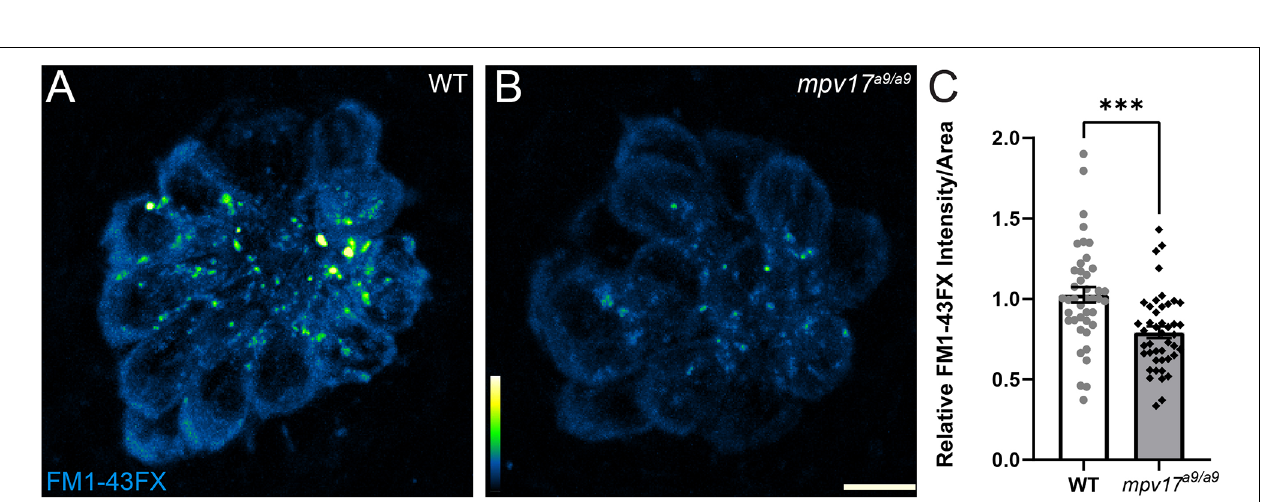
FIGURE 2 | mpv17 a9/a9 hair cells have hyperpolarized mitochondria. (A–C, E–G) Maximum-intensity projections of confocal images displaying WT (A–C) and mpv17 a9/a9 (E–G) neuromasts with DAPI-labeled hair cells (A–E) and staining with MitoTracker Red CMXRos (B–F) and MitoTracker Deep Red (C–G) . (D–H) Mean intensities for both MitoTracker Red CMXRos (D) and MitoTracker Deep Red (H) are elevated in mpv17 a9/a9 neuromasts ( ∗ P = 0.0469; ∗∗∗∗ P < 0.0001). n = 29–31 neuromasts (L3, L4, and L5); N = 4 experimental trials. Scale bar: 5 µ m. Error bars: SEM.